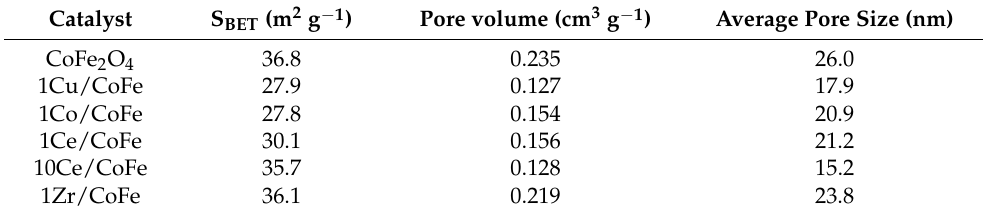
Table 1. Basic textural properties for the indicated